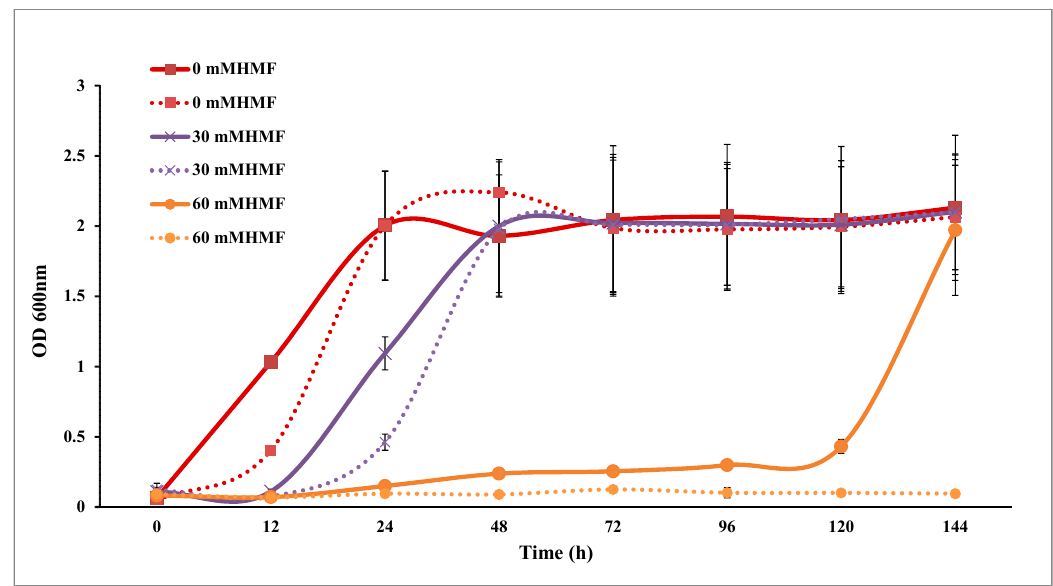
Figure 5. HMF tolerance analysis of Saccharomyces cerevisiae . Solid lines represent engineered strains; dashed lines represent wild strains.